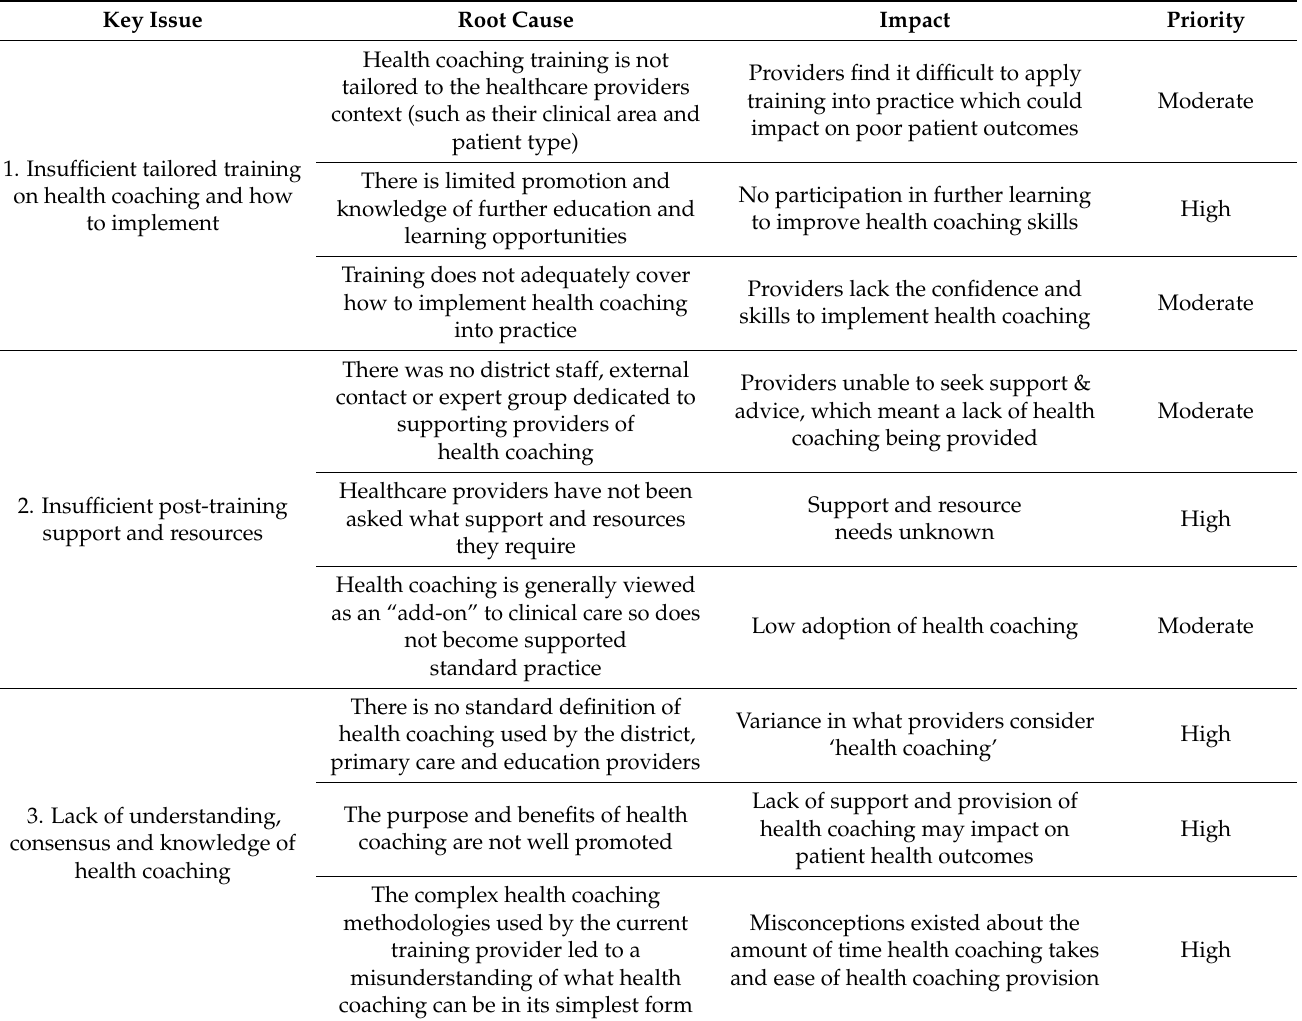
Table 1. Translating health coaching into practice—key issues, root causes, impact and